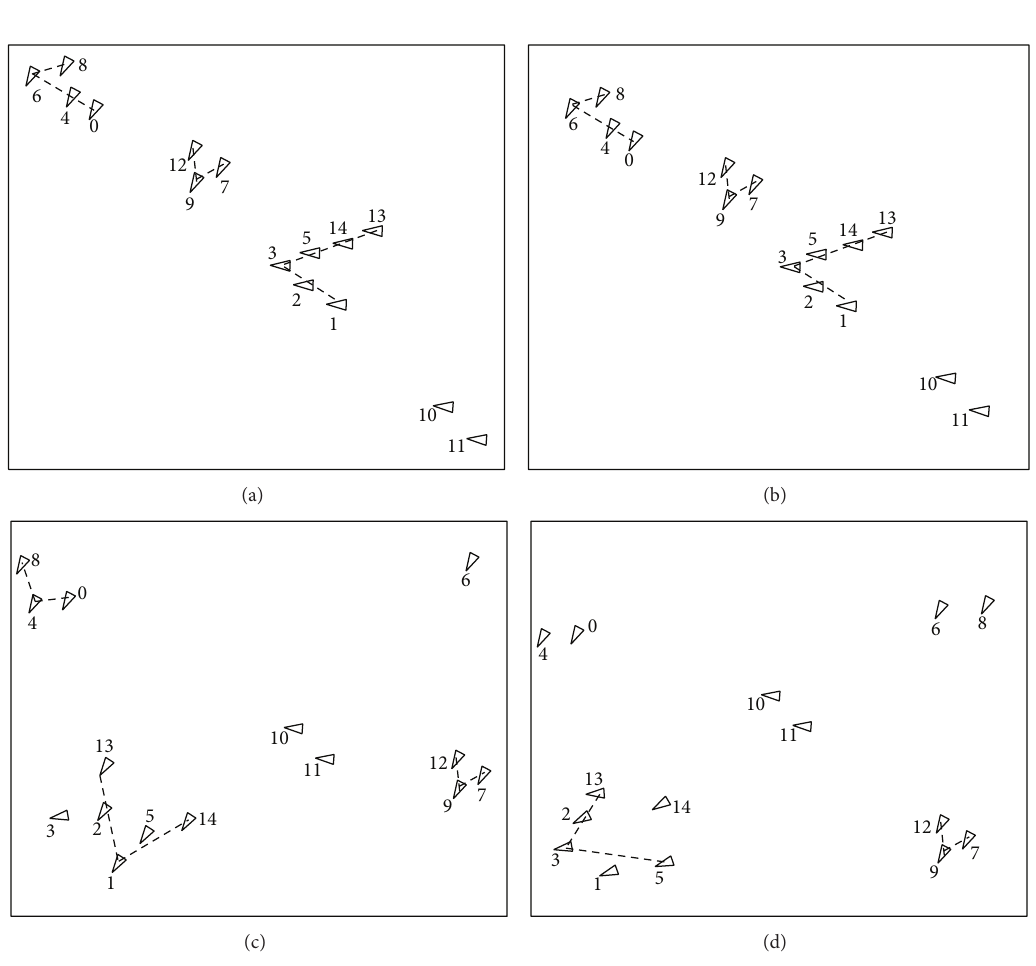
Figure 16: V-formations. Position of entities at ticks (a) 40200, (b) 40220, (c) 40380, and (d) 40400. the model classified several sets of entities as circular for- mations and around three remained throughout the 1200 ticks of a run. Regarding doughnut formations, the model detected around two formations that remained during the 1200 ticks of a run. These results agree with what was expected since Wilensky’s model had already stabilized in